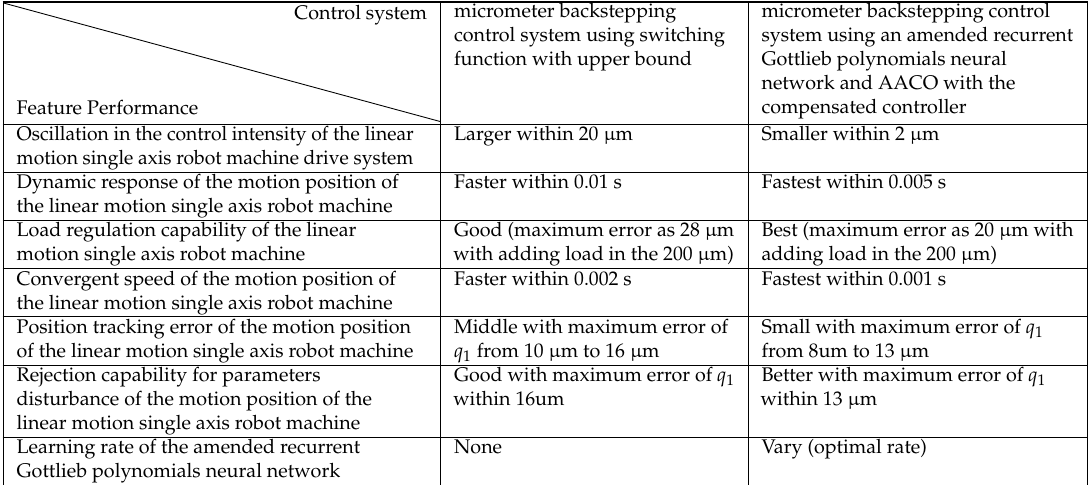
Table 2. Feature performance comparisons of control